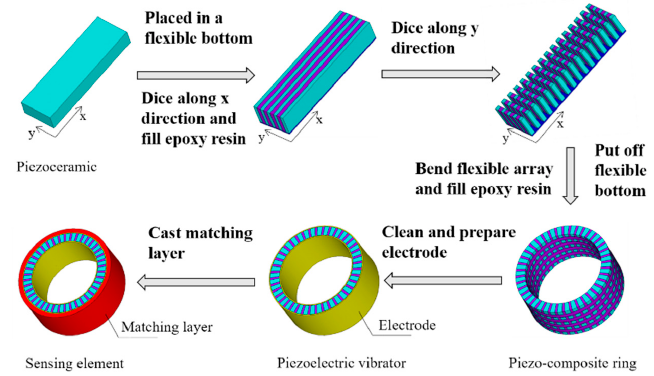
Figure 10. The fabrication flowchart of circular-shaped sensitive element.